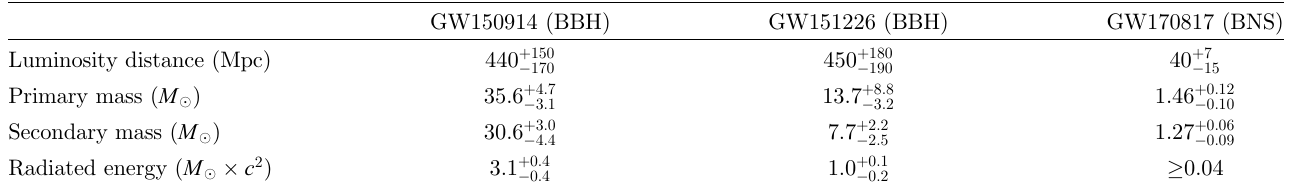
Table 1. Properties of the mergers reported in the GWTC-1-con fi dent catalogue, taken from the Gravitational Wave Open Science Center database, provided by the LIGO/Virgo collaborations [49, 50].